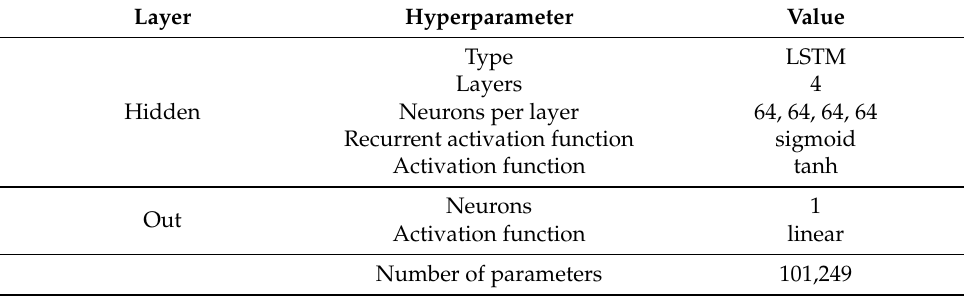
Table 6. Aiello’s architecture hyperparameters